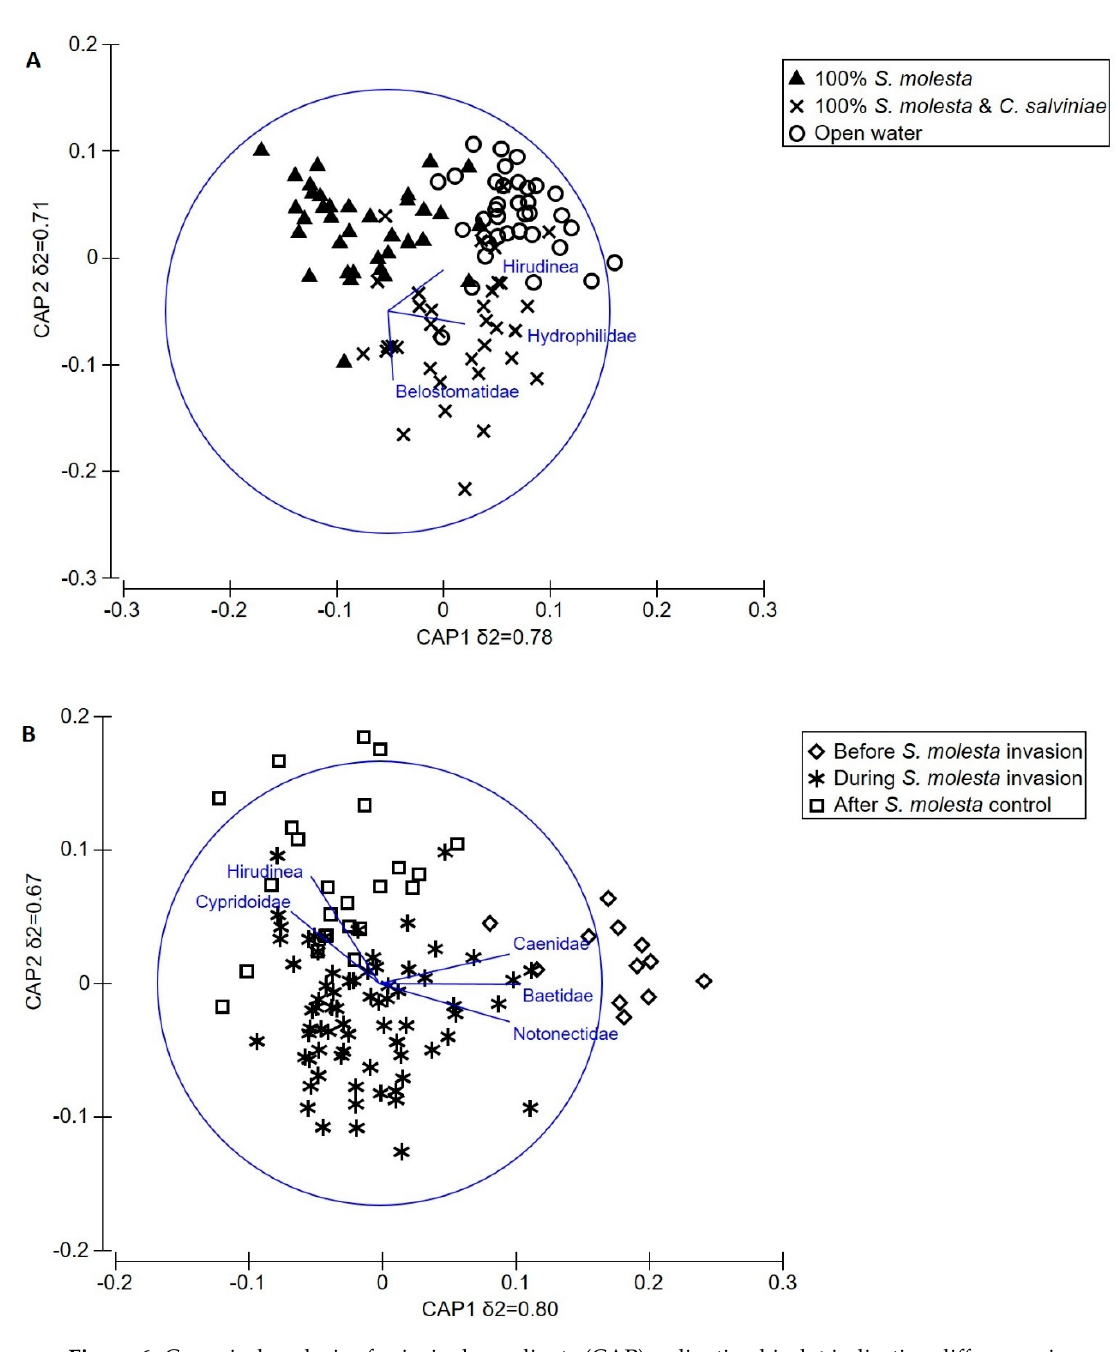
Figure 6. Canonical analysis of principal coordinate (CAP) ordination bi-plot indicating differences in aquatic macroinvertebrate assemblages found between treatments ( A ) and invasion phases ( B ) over 10 six-weekly sampling occasions. CAP δ 2 = indicating canonical correlation which is the percentage of explained assemblage variation per axis. Dominant taxa mean and standard deviation per treatment and invasion phase are presented in Table S3.